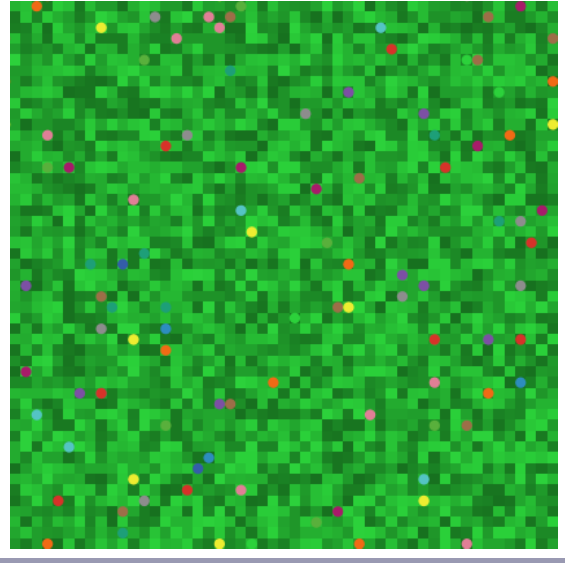
Fig. 1. Example of the state of the forest in the open- access model, represented in the graphic interface of NetLogo. This image symbolizes the mature forest at the setup phase of the simulation. Green indicates the amount of tree biomass: darker patches indicate lower tree biomass; lighter patches indicate higher tree biomass. Circles indicate loggers.